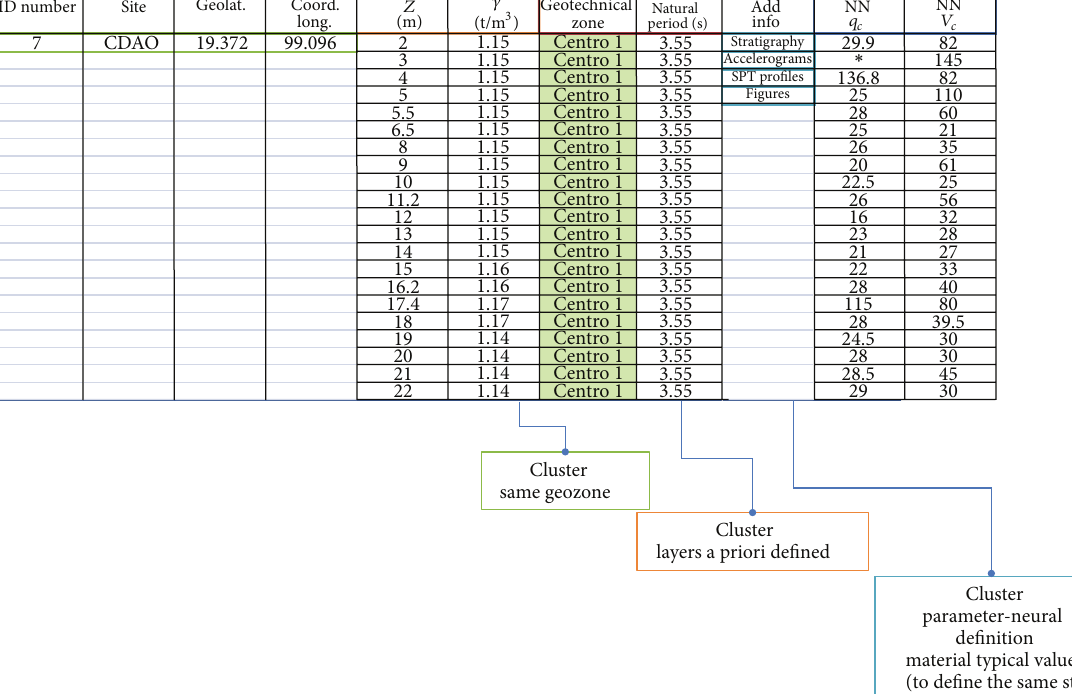
Figure 4: Schematic representation of Table 2: “real” borings geo- and seismic measurements. ID number Site Geolat.